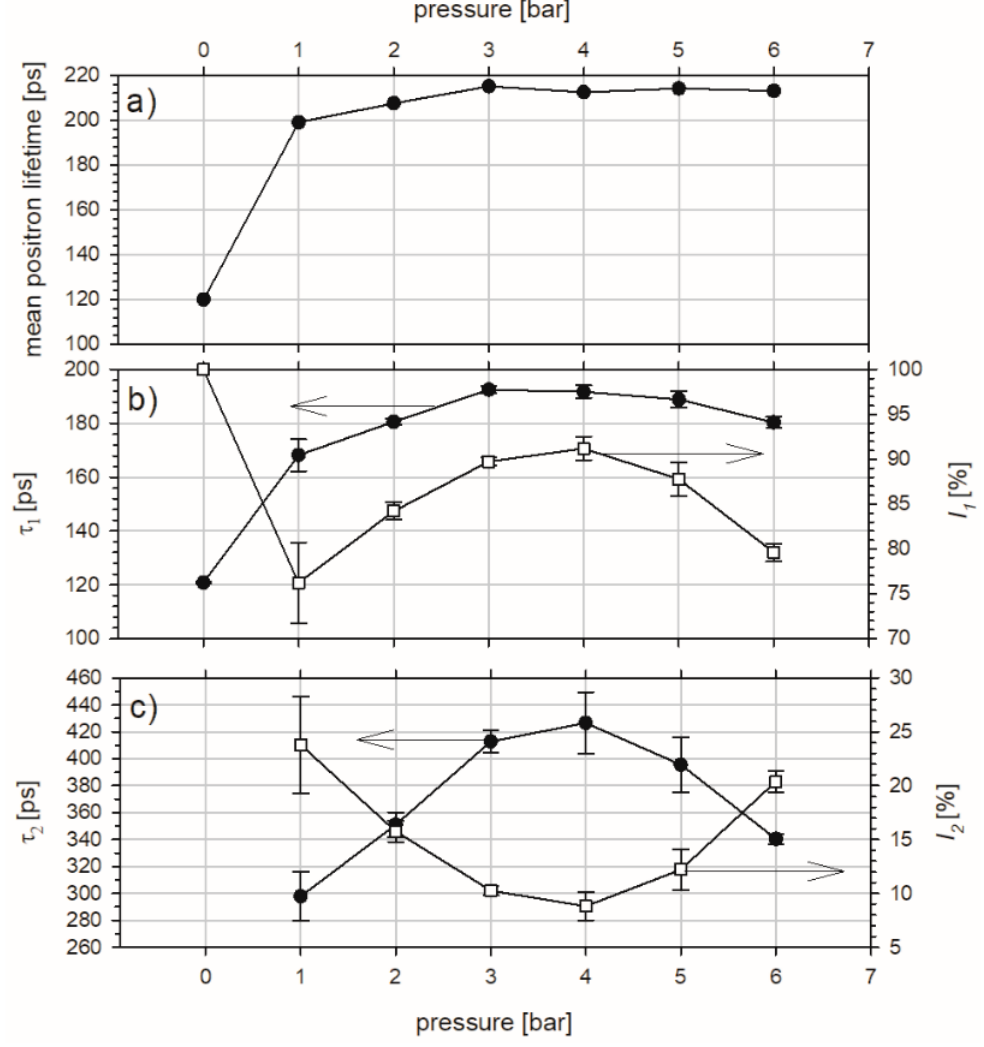
Figure 6. Dependencies of the mean positron lifetime τ ( a ), the first lifetime component with its intensity ( b ), and the second lifetime component with its intensity ( c ) on pressure obtained from the positron lifetime spectra measured for the copper samples exposed to sandblasting for 1 min with alumina particles.